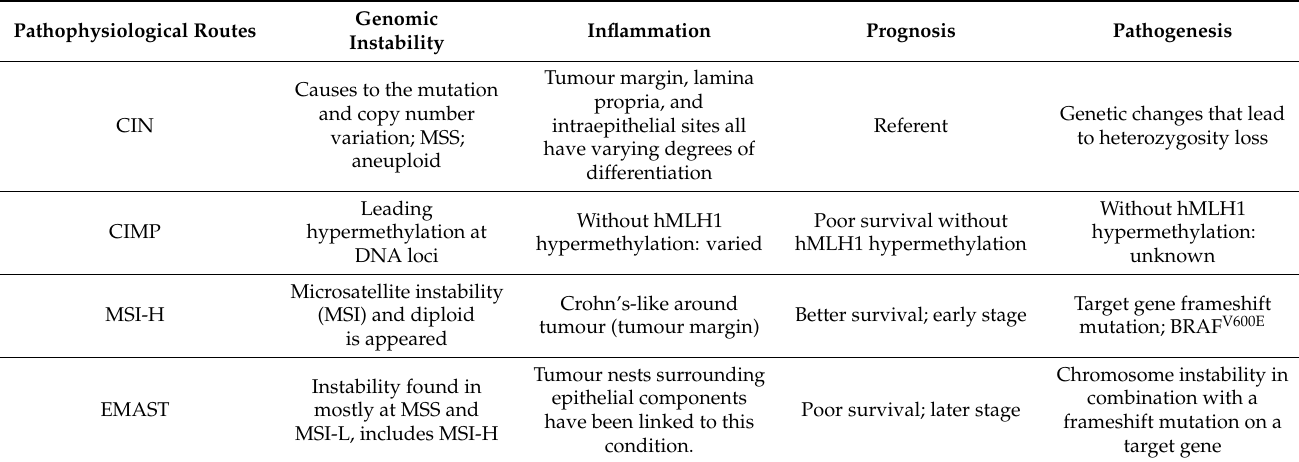
Table 1. An assessment of the MSI-H, EMAST, CIMP, and CIN CRC